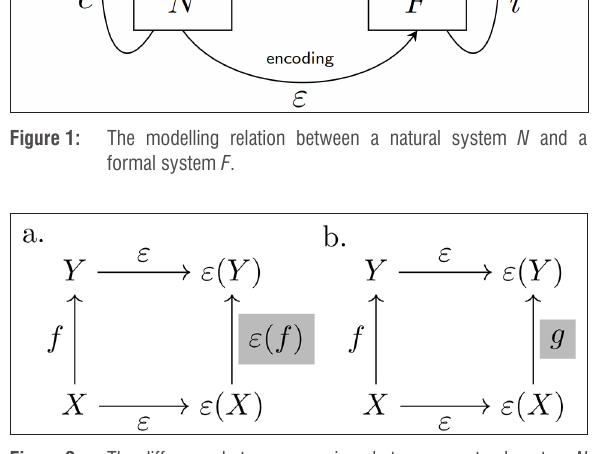
Figure 2: The difference between mappings between a natural system N and a formal system F in a (a) model and (b)